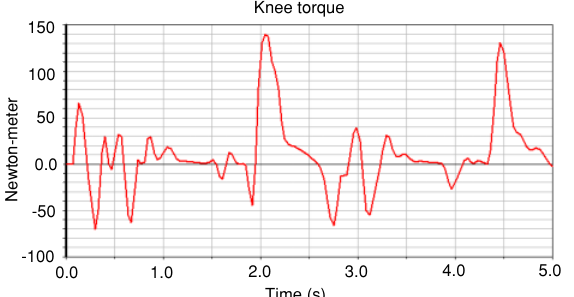
Figure 15 Knee flexion/extension torque.